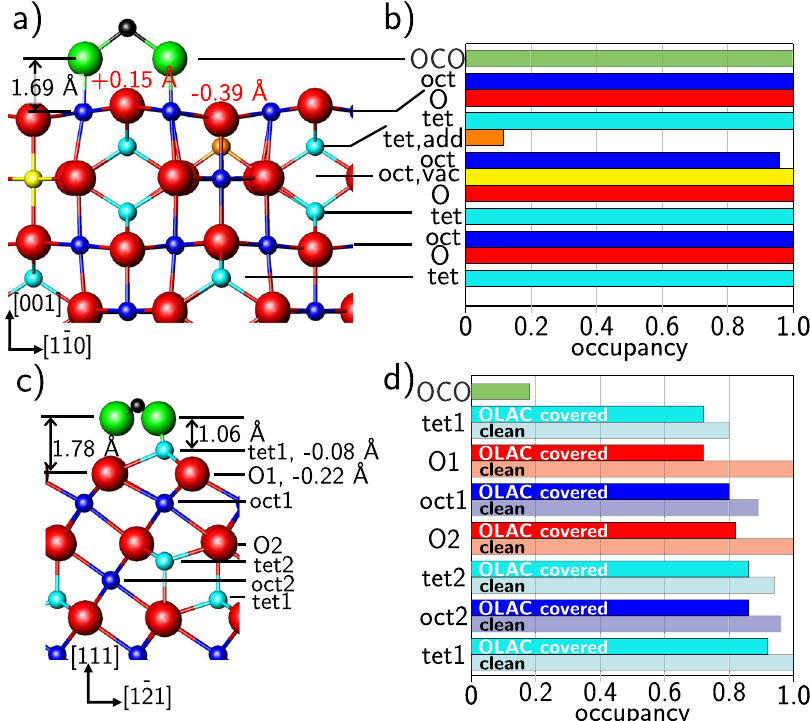
Fig. 2 Structural changes upon OLAC adsorption. Structural model obtained from SXRD fi t of magnetite (001) ( a ) and (111) ( c ) with atomic displacements with respect to the bulk positions. Figures ( b ) and ( d ) show the occupancy pro fi les obtained from the SXRD fi ts which correspond to the respective atomic layer of the unit cell in ( a ) and ( c ) for magnetite (001) and (111), respectively. Magnetite oxygen is shown in red, carboxylate oxygen in green, carbon in black, octahedral iron in blue, tetrahedral iron in light blue, octahedral vacancy sites in yellow and tetrahedral interstitial ions in